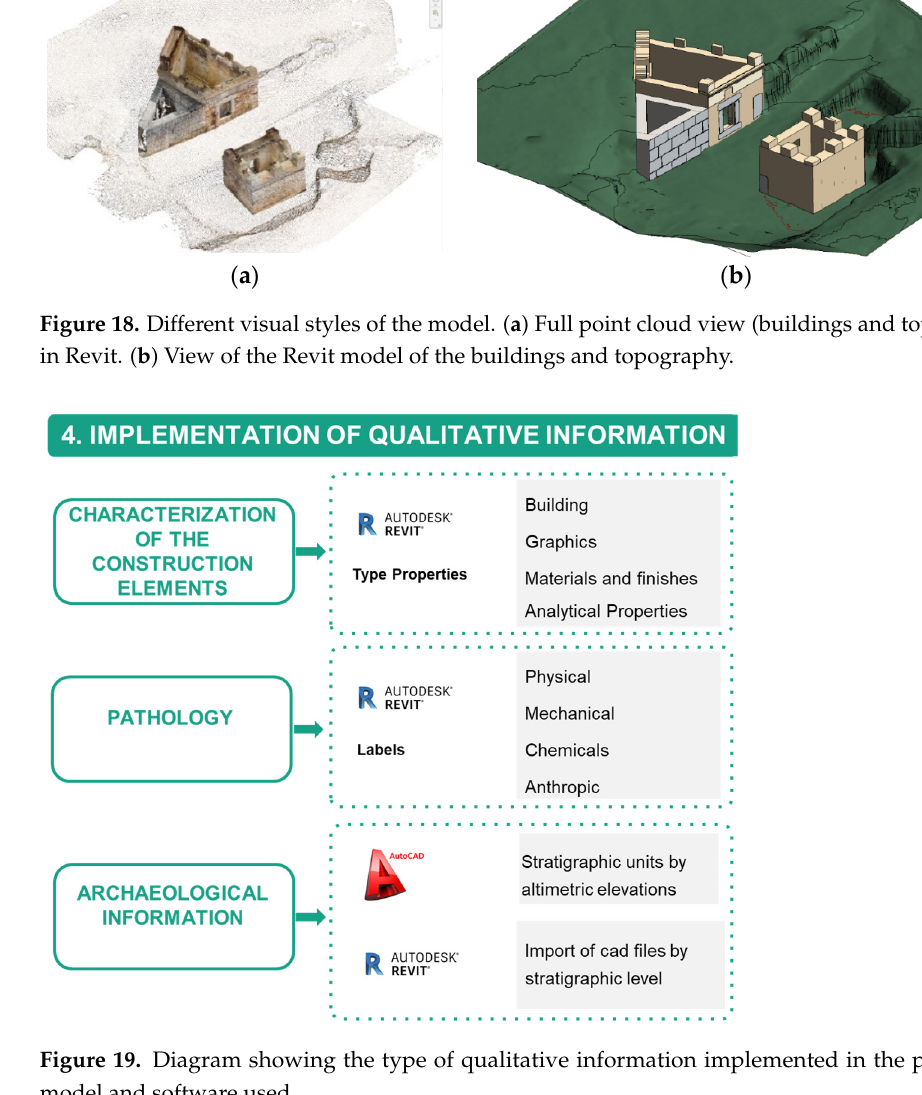
Figure 18. Different visual styles of the model. ( a ) Full point cloud view (buildings and topography) in Revit. ( b ) View of the Revit model of the buildings and topography.